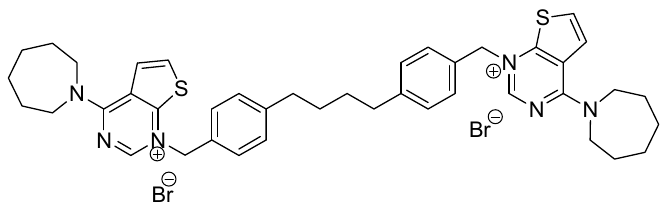
Figure 1. Chemical structure of choline kinase α 1 (ChoK α 1) inhibitor Ff35.